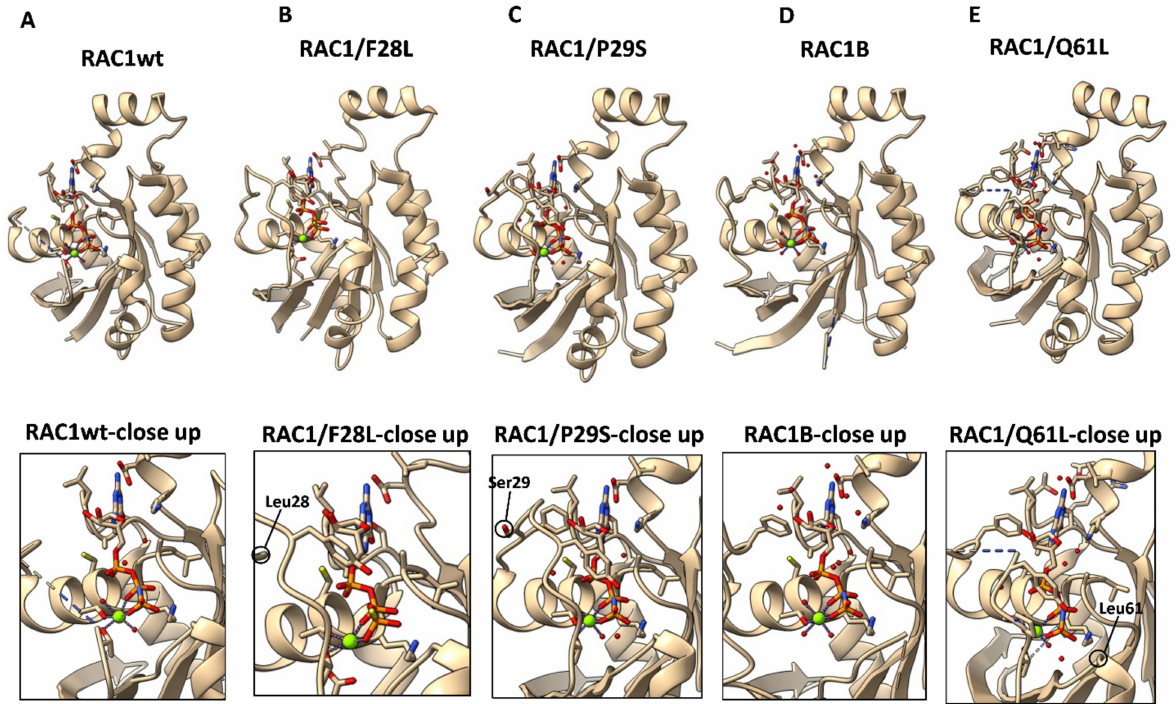
Figure 4. Three-dimensional structures of GDP-bound RAC1 variants. Structural information was collected from the PDB database. RAC1wt-GDP, 3TH5 ( A ); RAC1/F28L-GDP, 4GZM ( B ); RAC1/P29S- GDP, 3SBD ( C ); RAC1B-GDP, 1RYH ( D ); and RAC1/Q61L-GDP, 4GZL ( E ). Top: Overview. Bottom: Close-ups of GDP positioning. Images of the three-dimensional structures were generated with the USCF ChimeraX software (version 1.2, http://www.rbvi.ucsf.edu/chimerax) (version: 1.2.5 (24 May